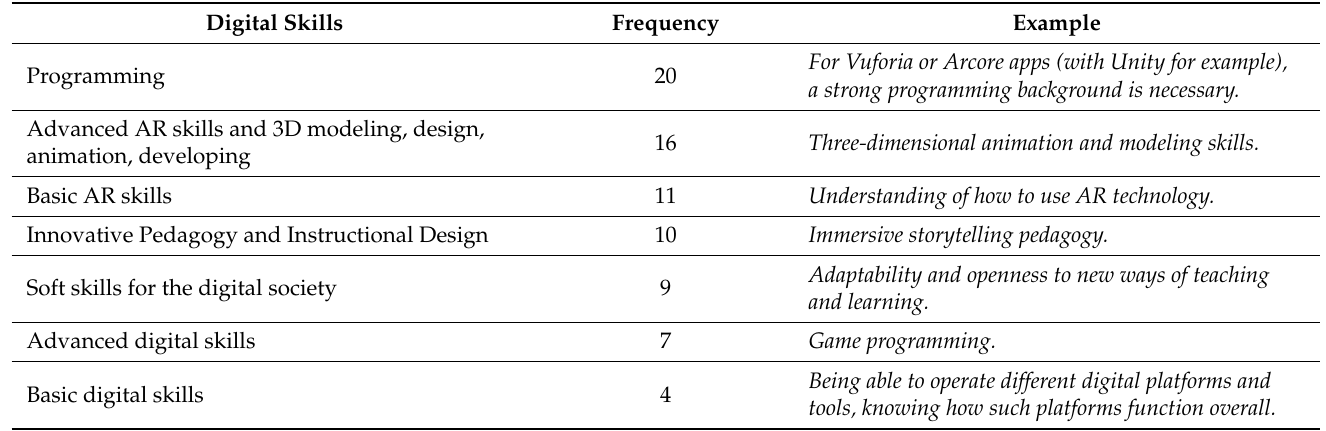
Table 3. Important teachers’ digital skills in order to integrate AR in